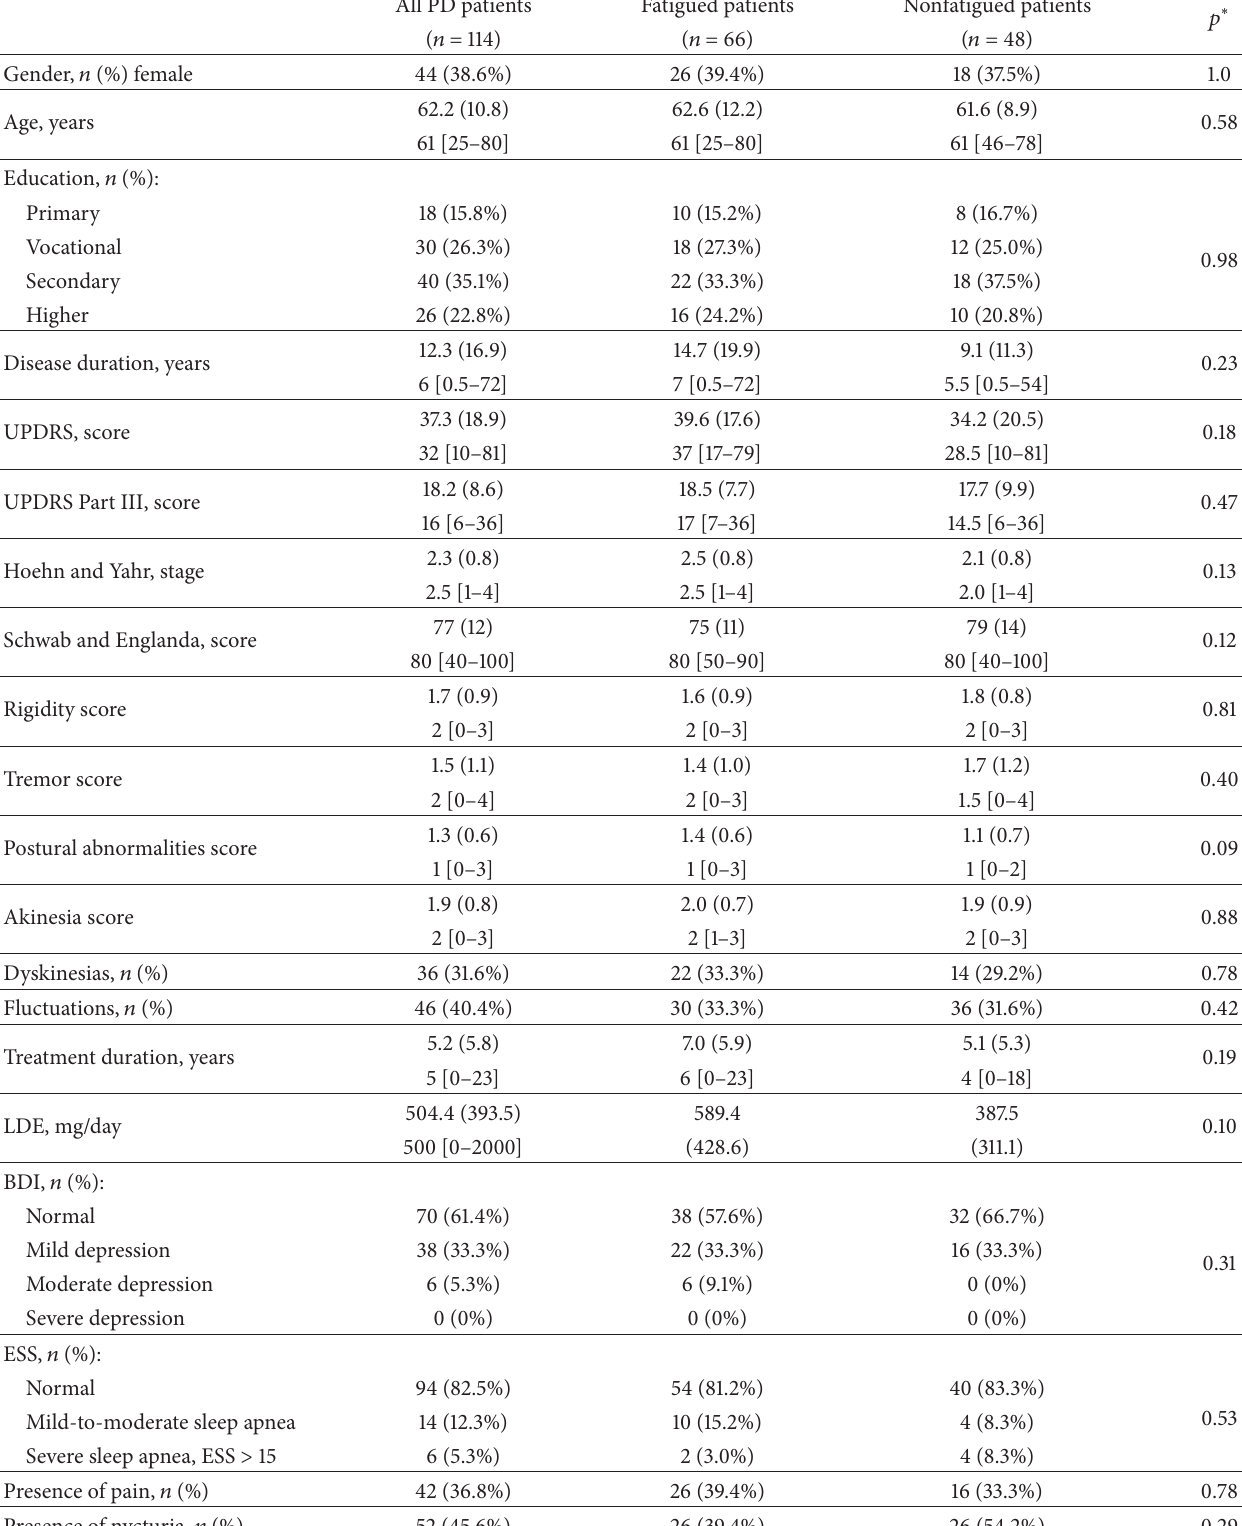
Table 2: Descriptive data for patients with PD and all patients and for patients with (FSS ≥ 4) and without (FSS < 4) fatigue